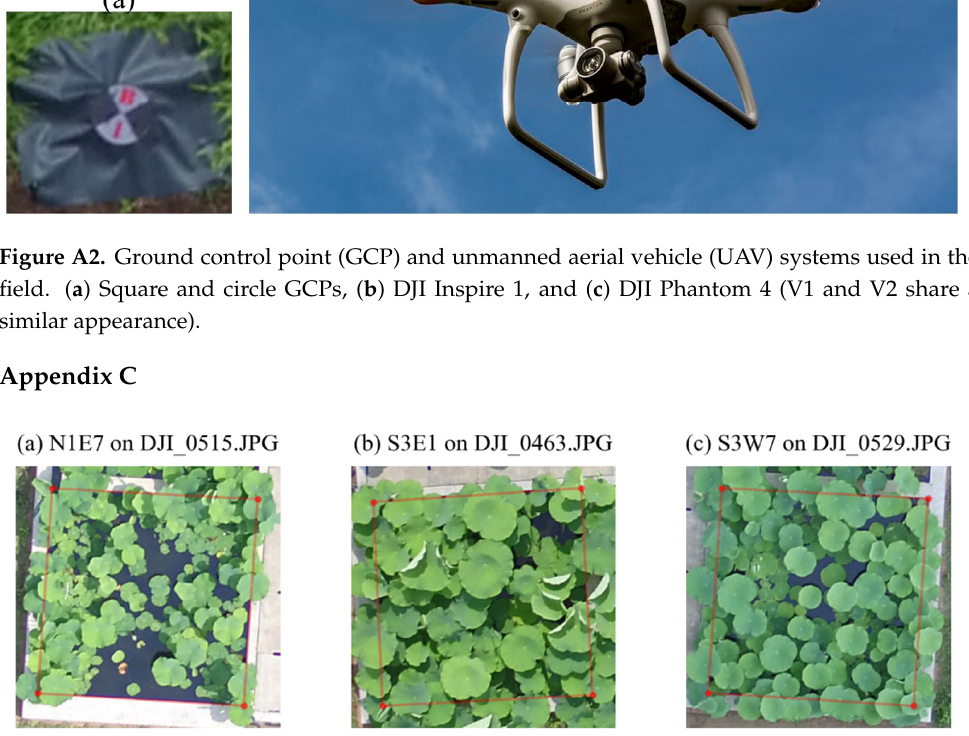
Figure A3. Complex examples for manually marking the expected (reference) transformation results. The plot corner or edge is partly or mostly covered by lotus leaves and cannot be identified.